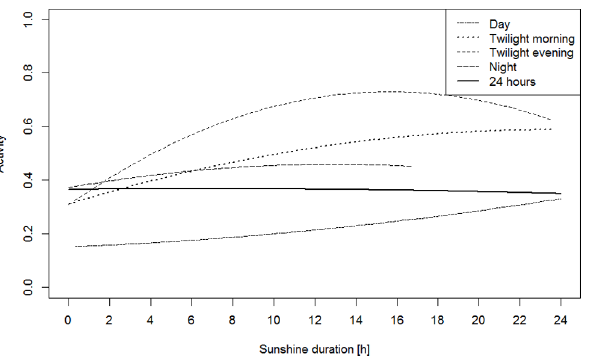
Fig. 5. Lynx activity predicted by the linear mixed additive model for the response variable portion of time spent active (activity) for one 24–h period (whole day) and during the phases day, twilight morning, twilight evening and night depending on daylight duration. Each covariable is predicted for the reference category adult, female, autumn, Bavaria–Czech Republic, full moon ( 5 0); therefore, only daylight influences the